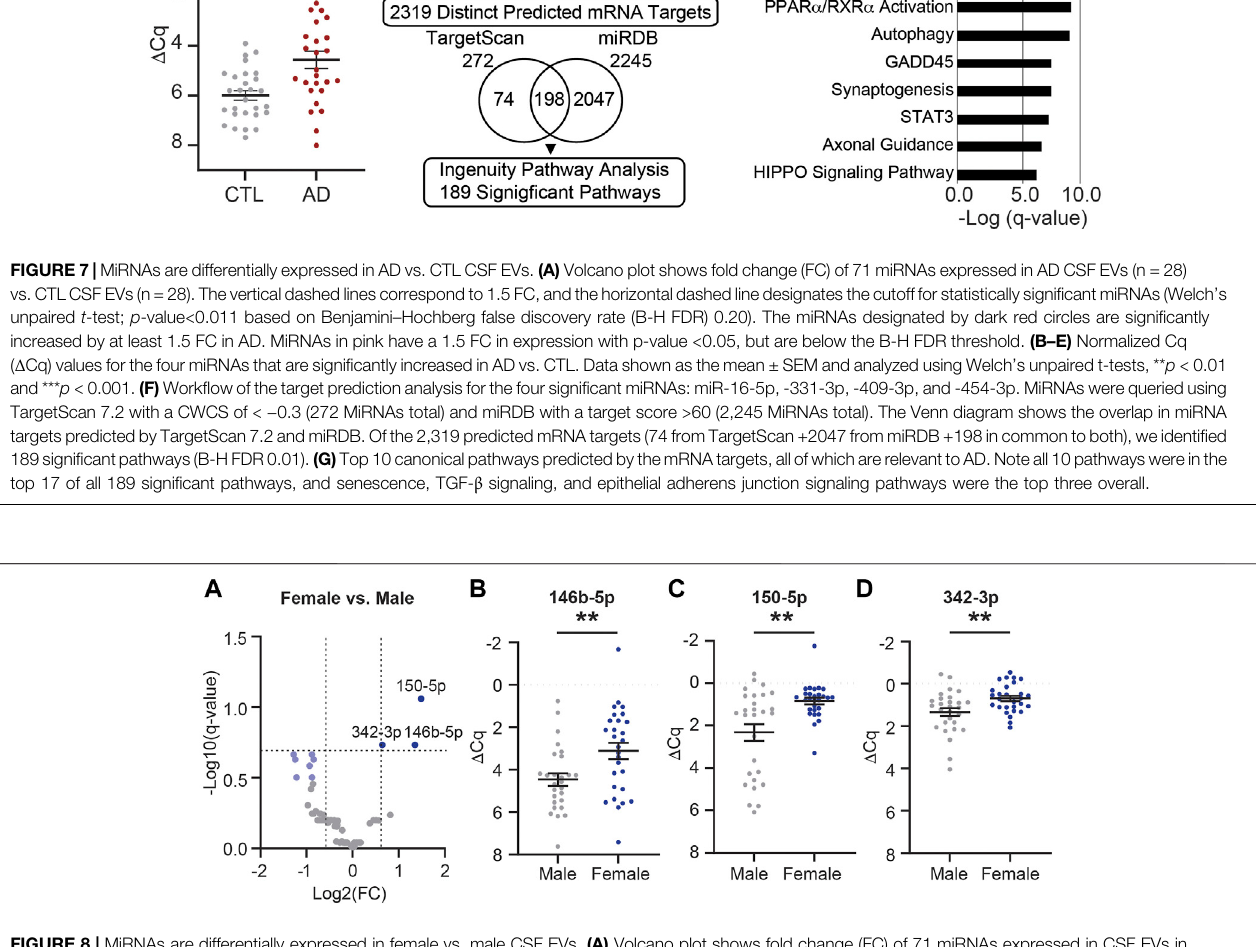
Frontiers in Cell and Developmental Biology |